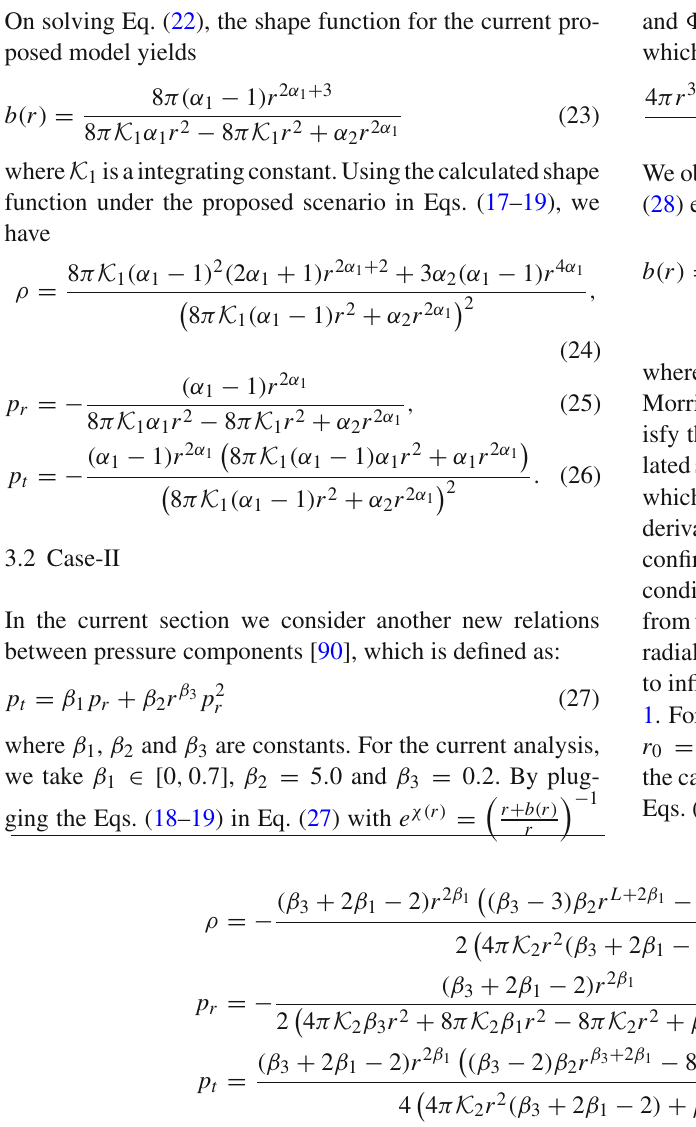
On solving Eq. (22), the shape function for the current pro- posed model